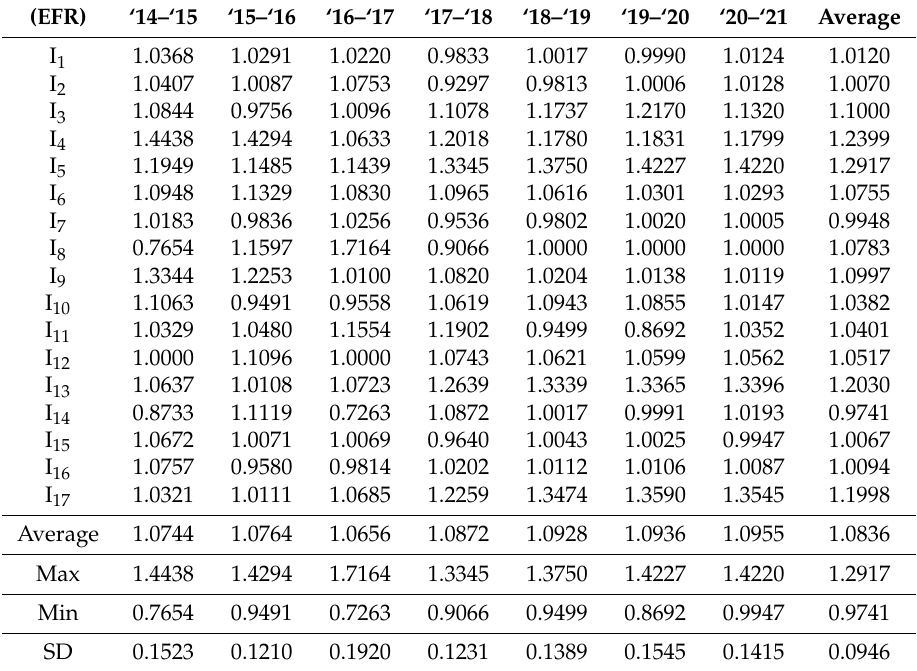
Table 16. Frontier